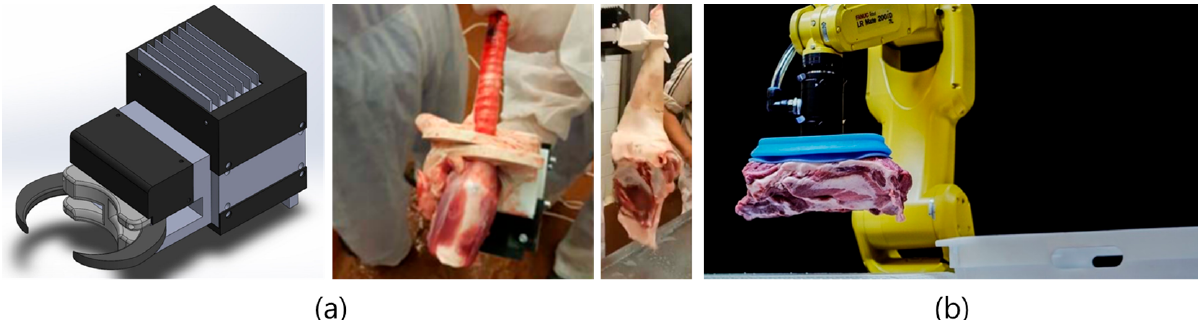
Figure 10. Different types of automated grippers for meat processing. ( a ) a dual propose gripper [75] (from Takács B. Inner organ manipulation during automated pig slaughtering-smart gripping approaches. Reprinted with permission of IEEE, New York, Copyright © 2021). ( b ) A DMRI vacuum-type gripper for the meat processing line (Reprinted with permission of DMRI, Danish Technological Institute).